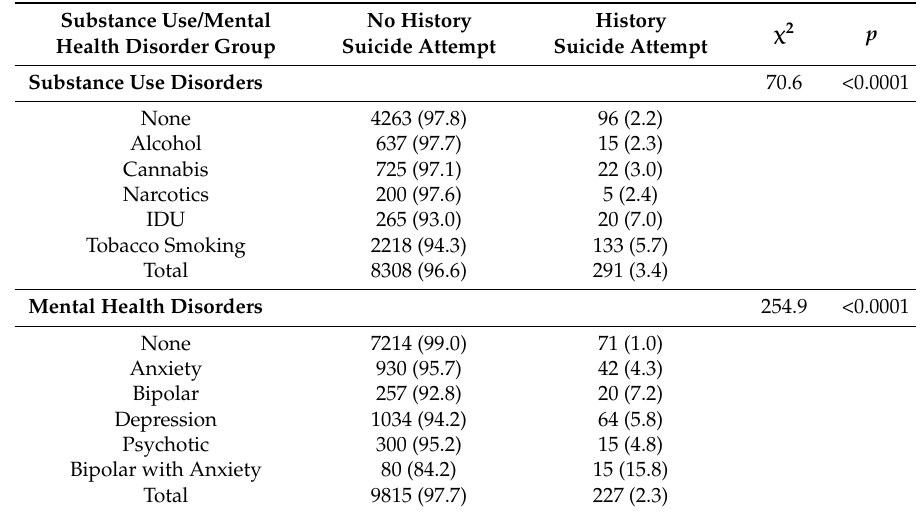
Table 6. Within group differences for suicide attempts.